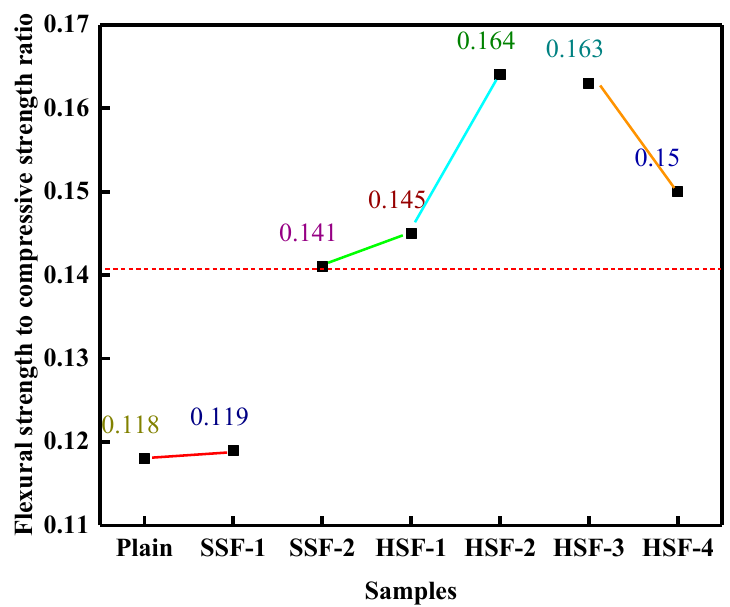
Figure 4. Ratio of flexural strength to compressive strength of FRC.